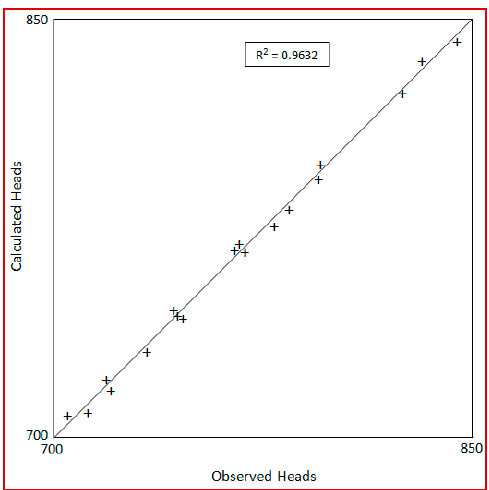
Figure 6. Relationship between calculated and observed heads in meters (May